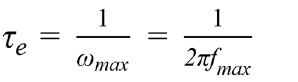
and AuNP@SnO photoanodes. 2 2